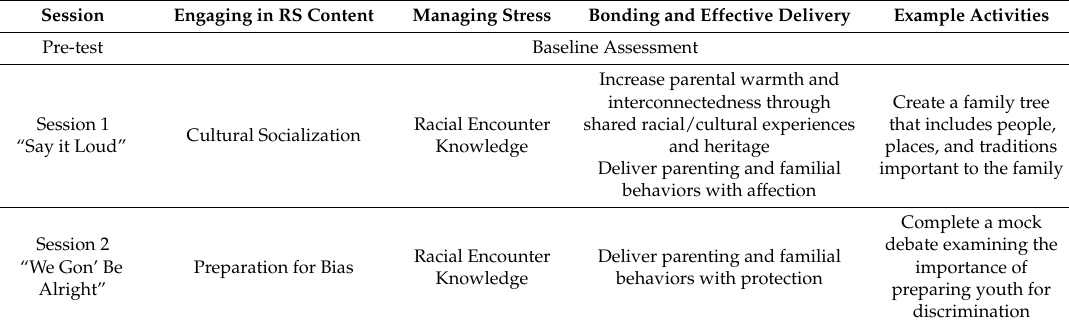
Table 1. Overview of the EMBRace intervention: targeted skills, content, and example